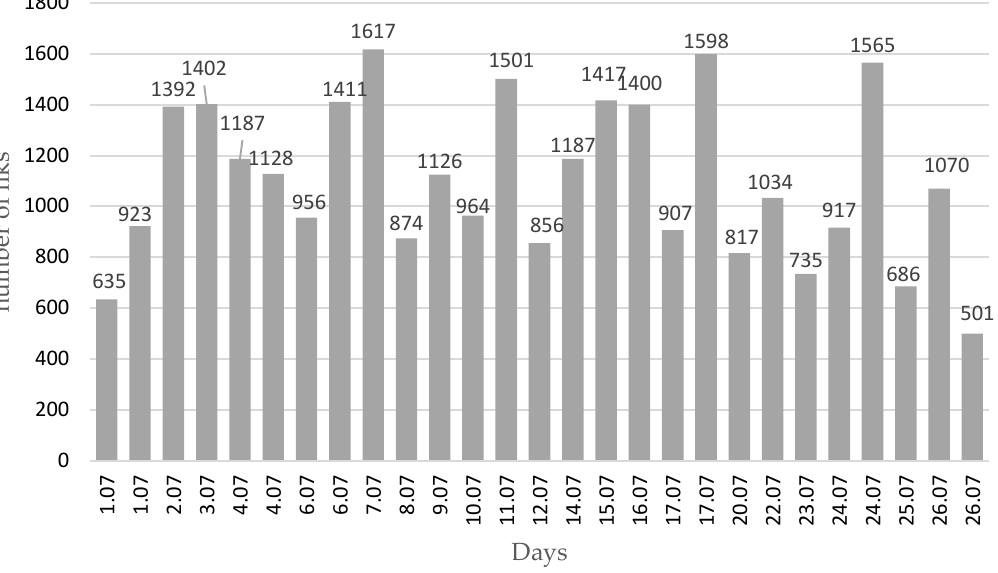
Figure 5. Number of likes for published materials on Instagram. Source: authors’ own elaboration based on Instagram data.